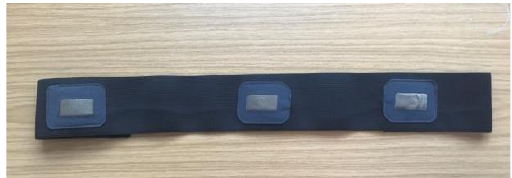
Figure 6. The chest band for wearable ECG measurement.